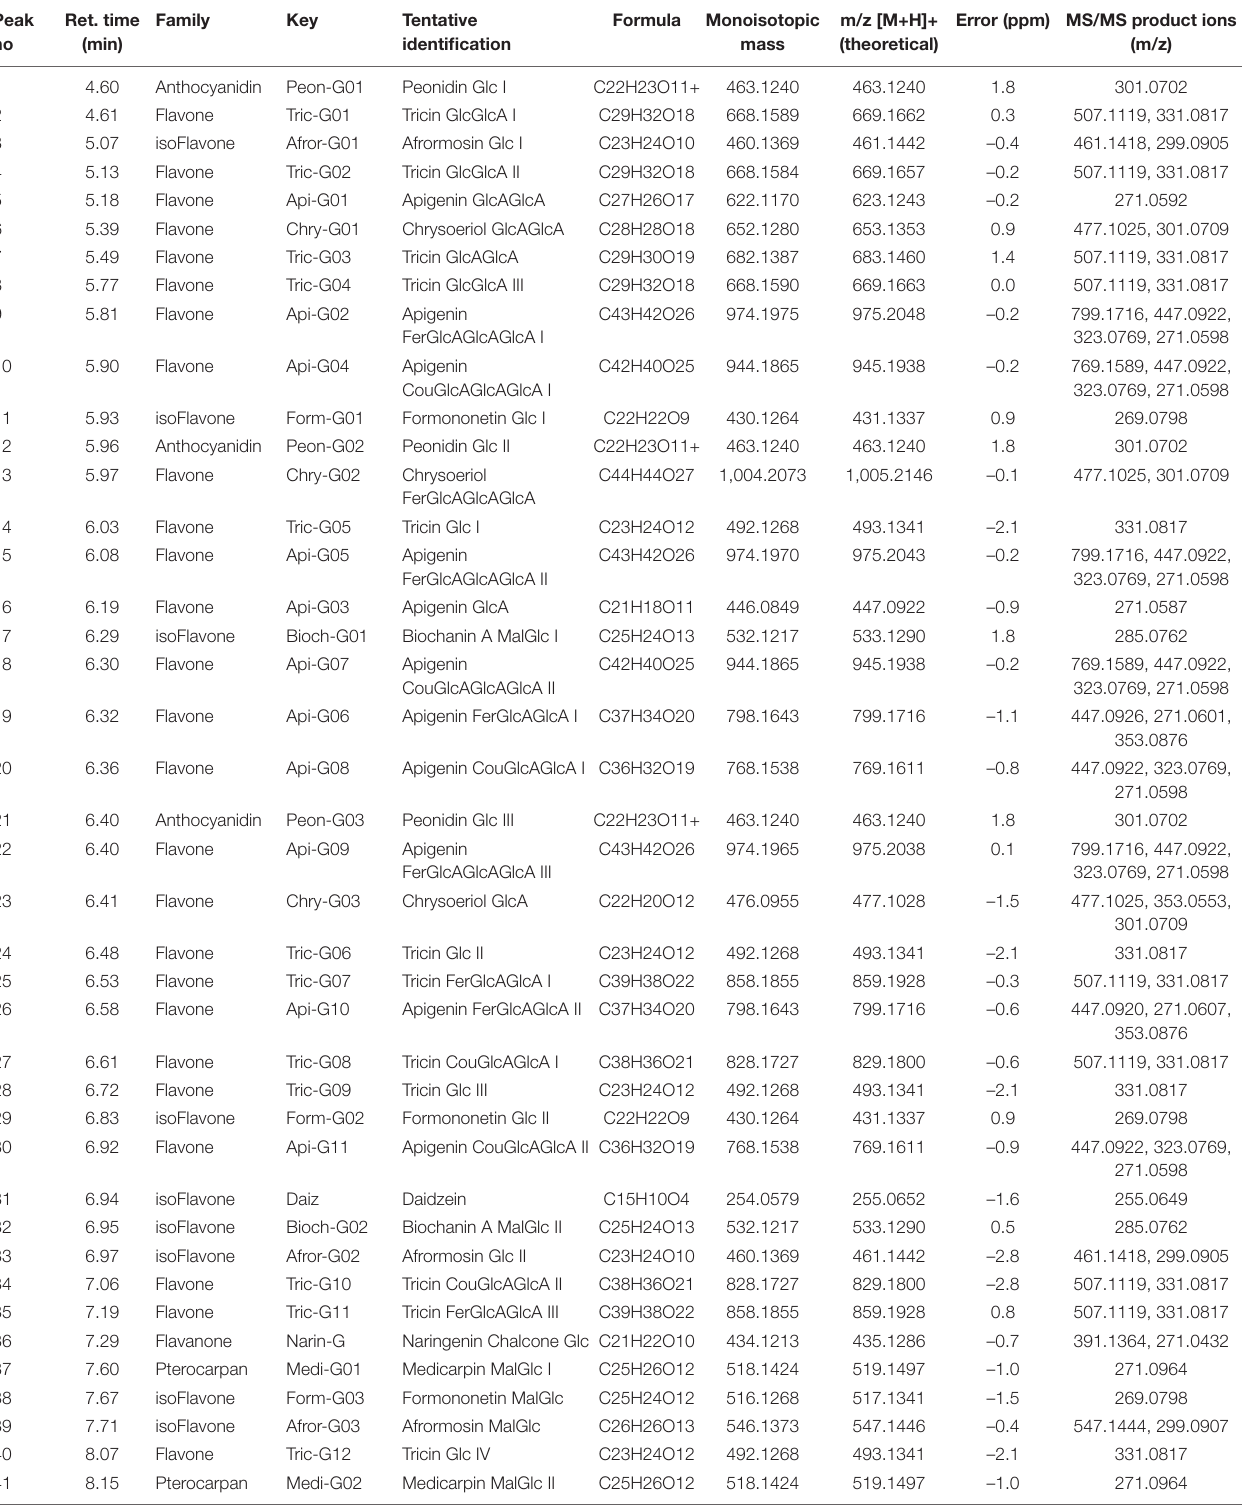
TABLE 1 | Tentatively identified flavonoids and their glycoconjugates from Medicago truncatula roots and leaves by ESI(+)-q-TOF-MS/MS analysis, including the retention time (min), molecular formula, experimental molecular ions, calculated mass error ( (cid:49) m/z, ppm), and MS/MS product ions. Peak Ret. time no